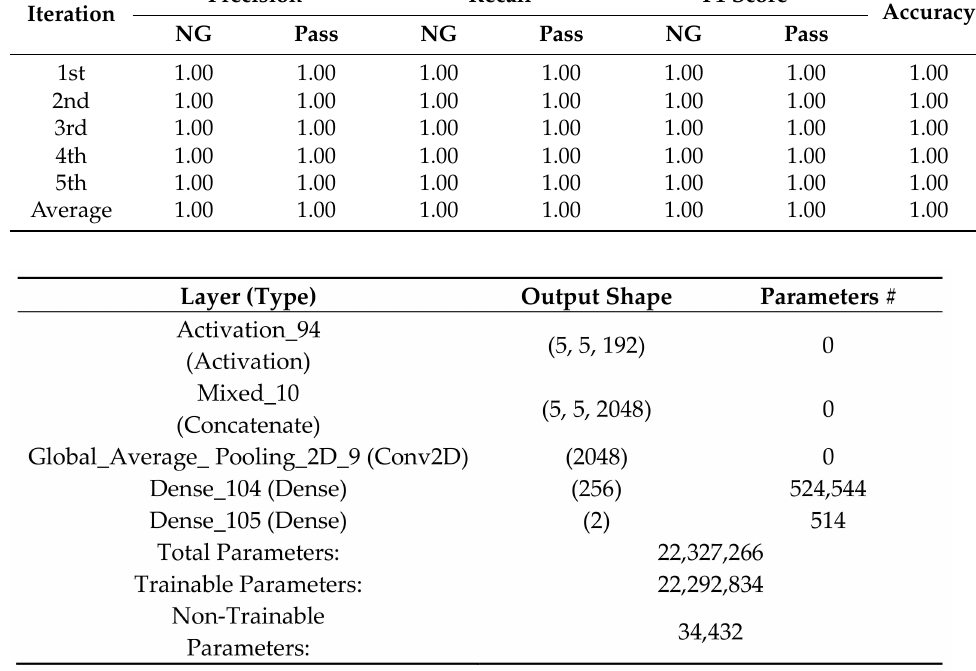
Figure A2. InceptionV3 + GAP Layers